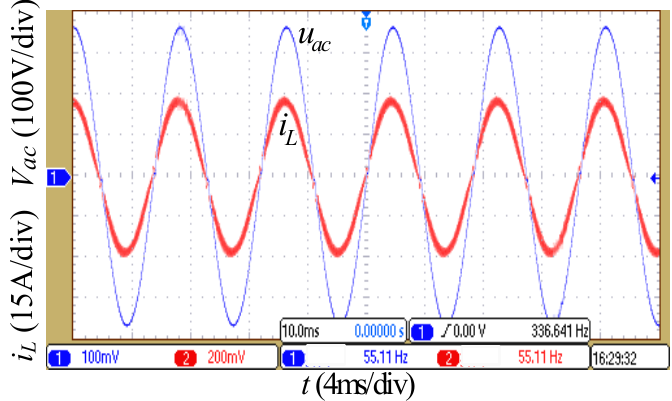
Figure 23. Voltage and current under the FSAPIR controller.